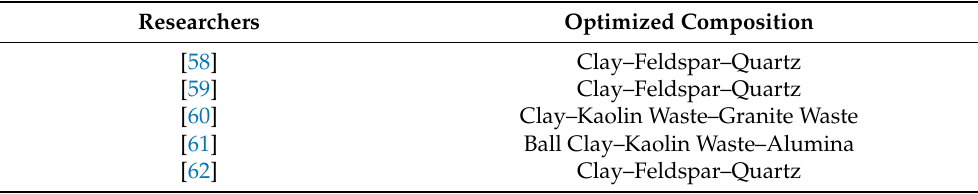
Table 1. Optimized composition (design of mixture experiment) of clay-based